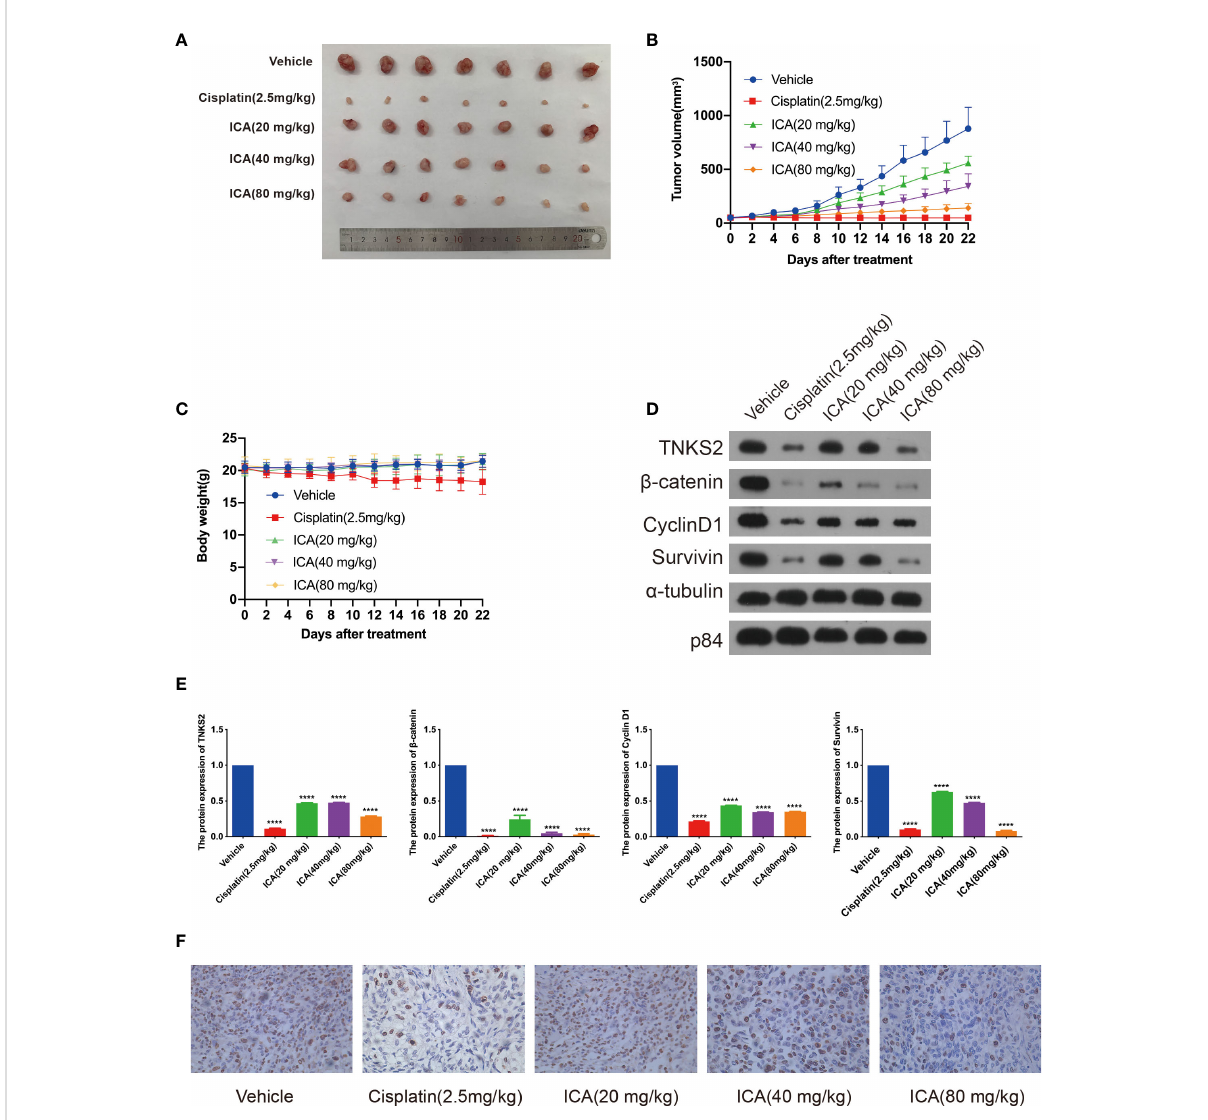
FIGURE 6 Icariin suppresses tumor growth in xenograft mouse model. (A) Representative photograph of the dissected tumors. (B, C) Tumor volume and bodyweight were detected twice a week. Data were presented as the mean±SEM. (D, E) Tumors were lysed, and the indicated proteins were analyzed by Western blotting (n=3). Data were presented as the mean±SEM. Signi fi cance by Dunnett ’ s test: ****p<0.0001. (F) Representative IHC images of Ki-67 expression in tumor tissue samples from the fi ve groups, ×400 magni fi